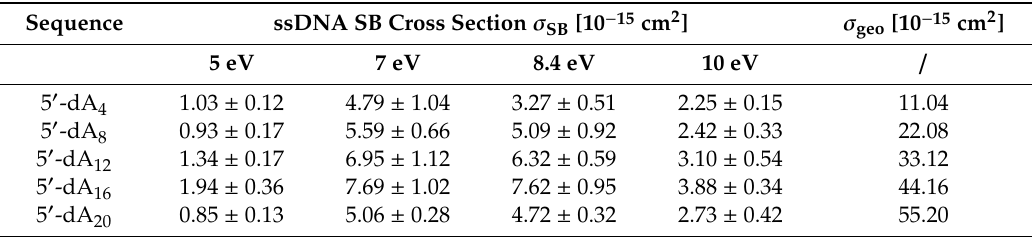
Table 1. Overview of the absolute cross sections for SBs( σ SB ) for the di ff erent DNA sequences upon electron irradiation at di ff erent energies compared to the geometrical cross section ( σ geo